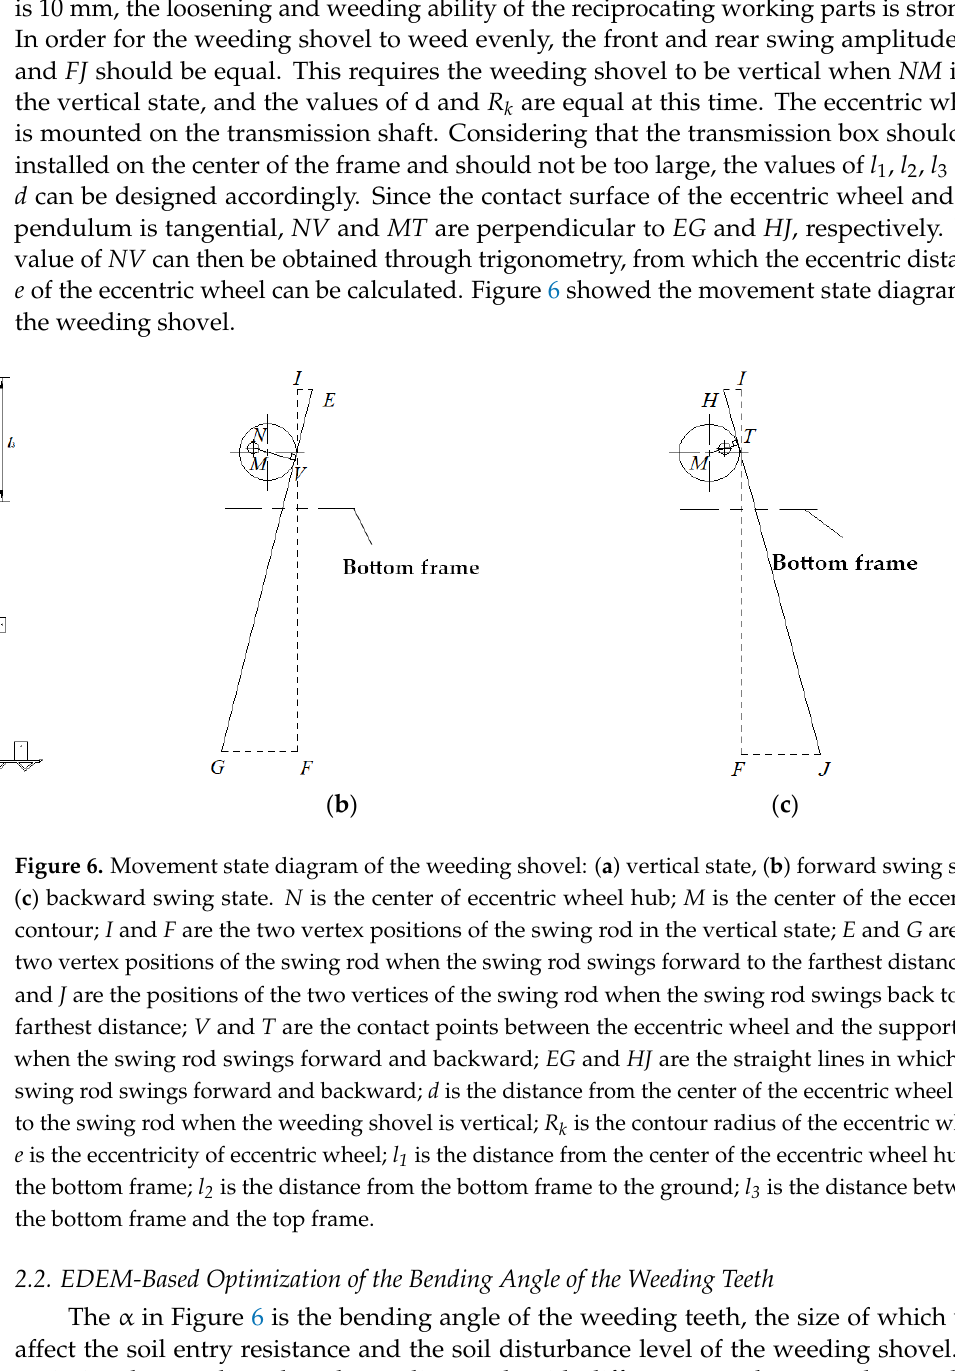
6 of 14 Figure 5. Bottom structure of weeding board. 1. Slide structure 2. Weeding teeth. The eccentric wheel rotates, driving the weeding shovel immediately adjacent to the eccentric wheel in a reciprocating motion. Due to this reciprocating motion, the trace of